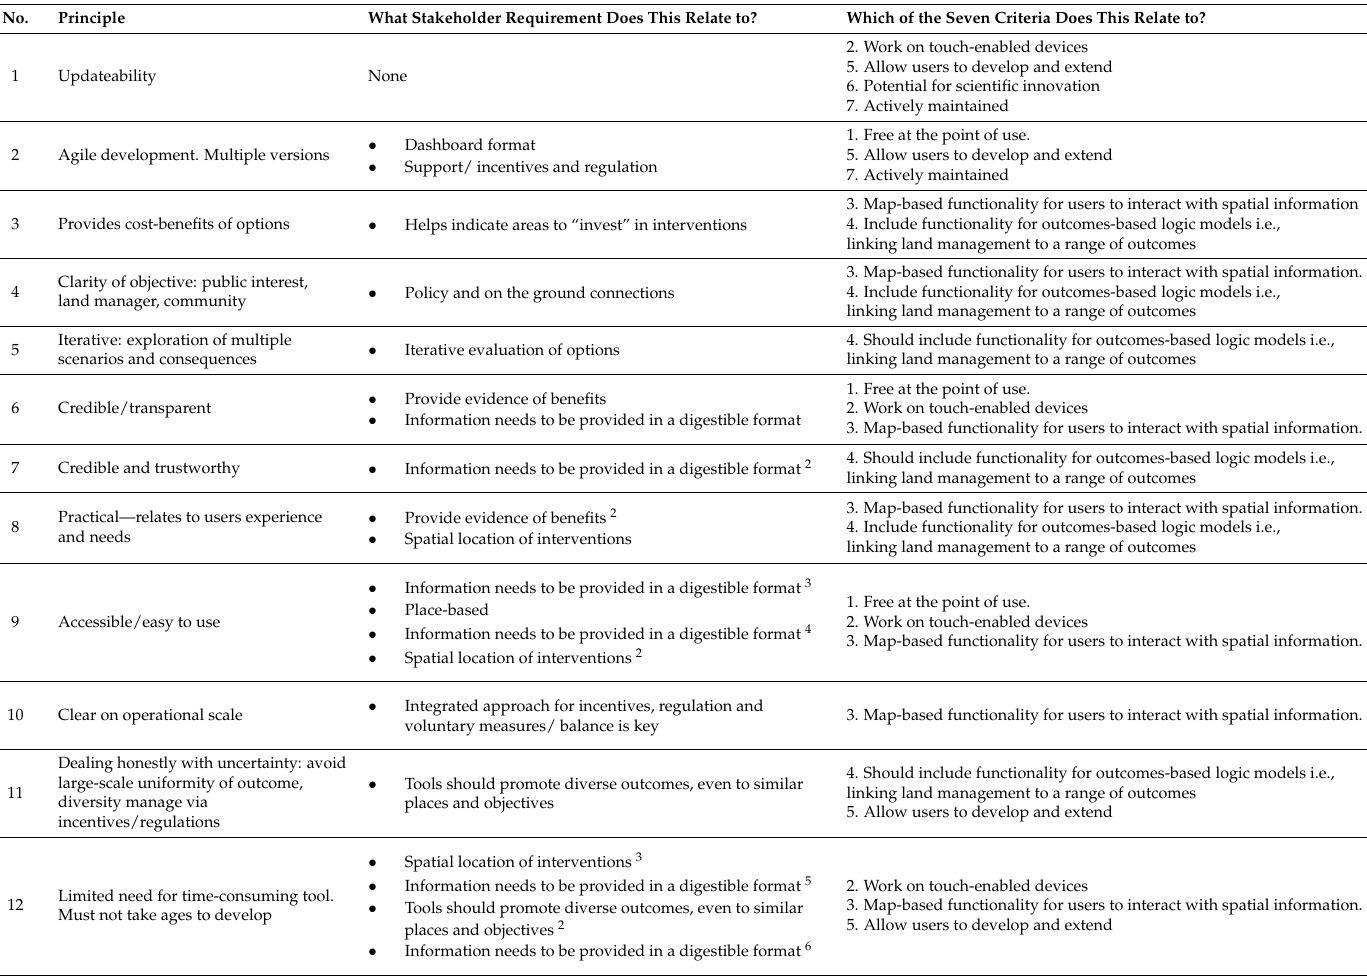
Table 2. Workshop participants’ 12 principles related to stakeholder requirements (centre) and our own list of 7 proposed criteria